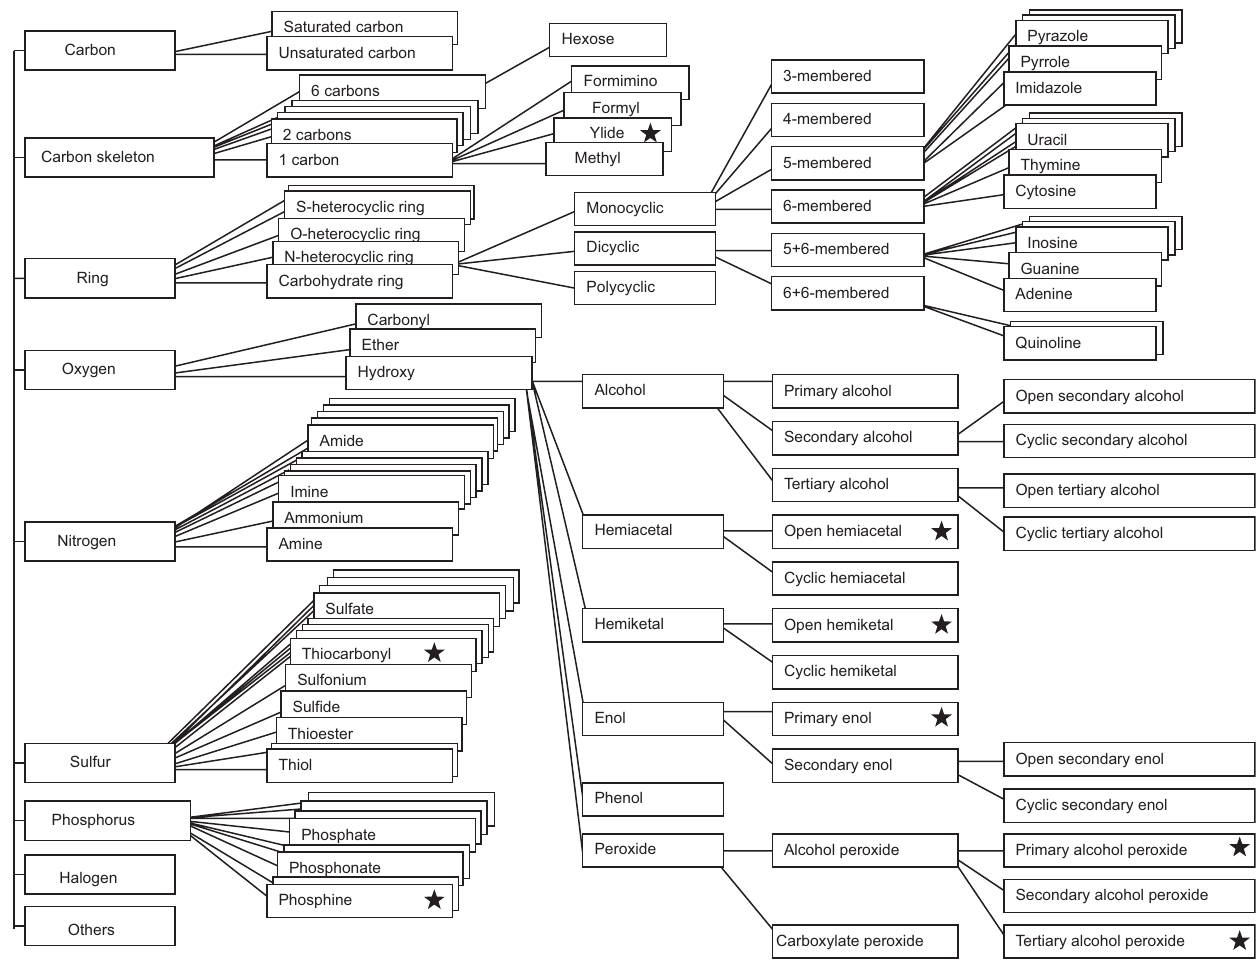
Figure 1. Partial classification tree of FGROUP: stars indicate FGROUP entries on which no enzymes are known to act. A complete list of FGROUP entries can be seen at http://bisscat.org/fgroup.html.